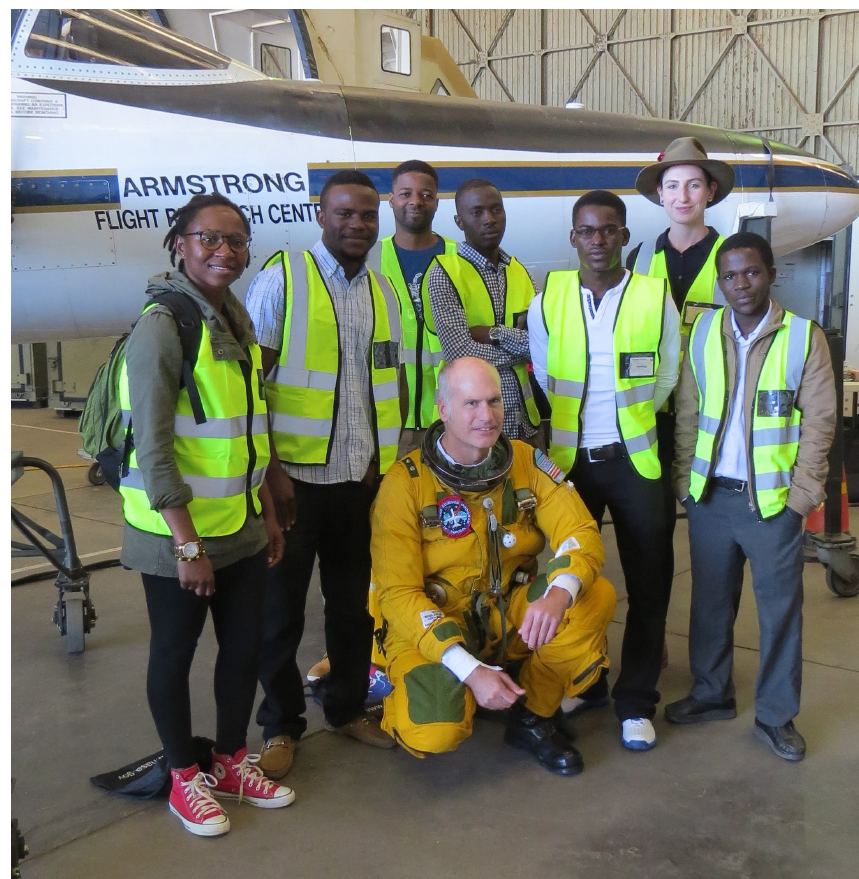
Figure 4. The ORACLES guest students, together with ER-2 pilot, James Gregory Nelson, at the Walvis Bay